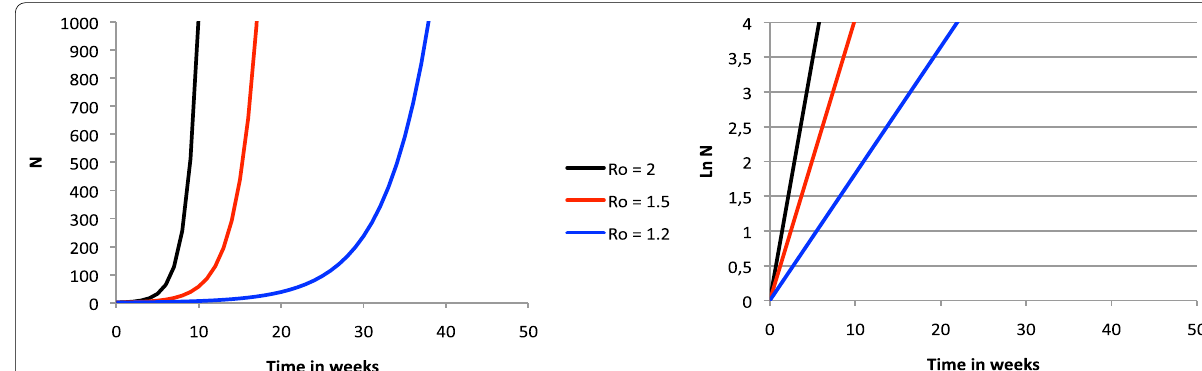
Fig. 1 Theoretical evolution of the number of infected patients for three different R o , assuming that the infectious time is 1 week. Exponential curves may be linearised by plotting Log N (right panel) on the y-axis instead of N (left panel)